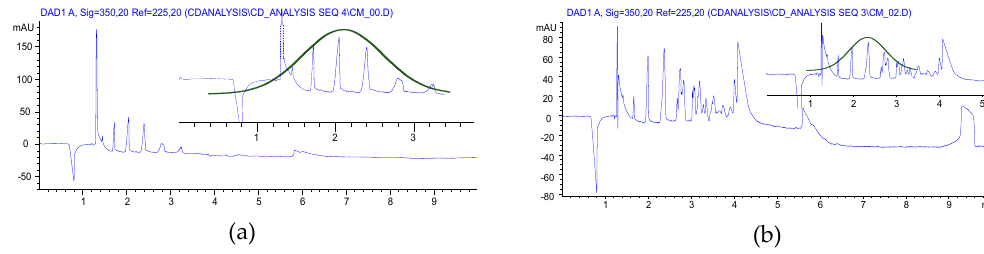
Figure 1. Capillary electropherograms of carboxymethylated β CD ( a ) synthesized in solution (compound 2, item 1 in Table 1); ( b ) synthesized in ball mill (compound 2 (cid:48) , item 3 in Table